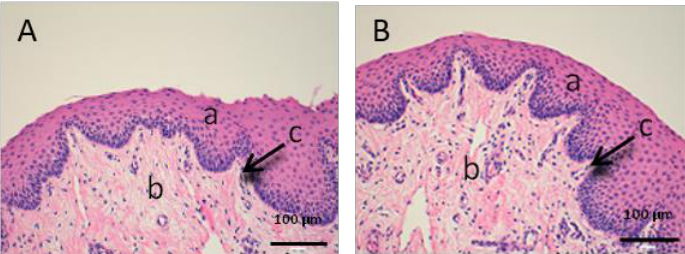
Figure 6. Histological images of vaginal mucous. ( A ): Untreated vaginal mucous observed at 400 × and ( B ): Vaginal mucous treated with CP-Sat observed at 400 × . a: stratified flat keratinized epithelium; b: own laminate and c: basal layer.